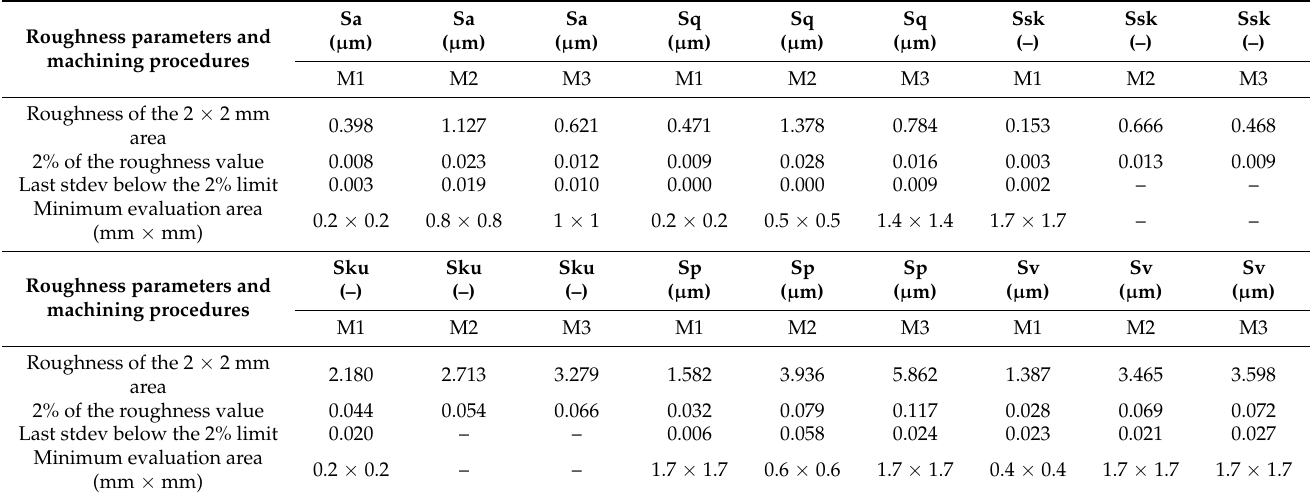
Table 4. Designated minimum evaluation areas based on the 2% standard deviation